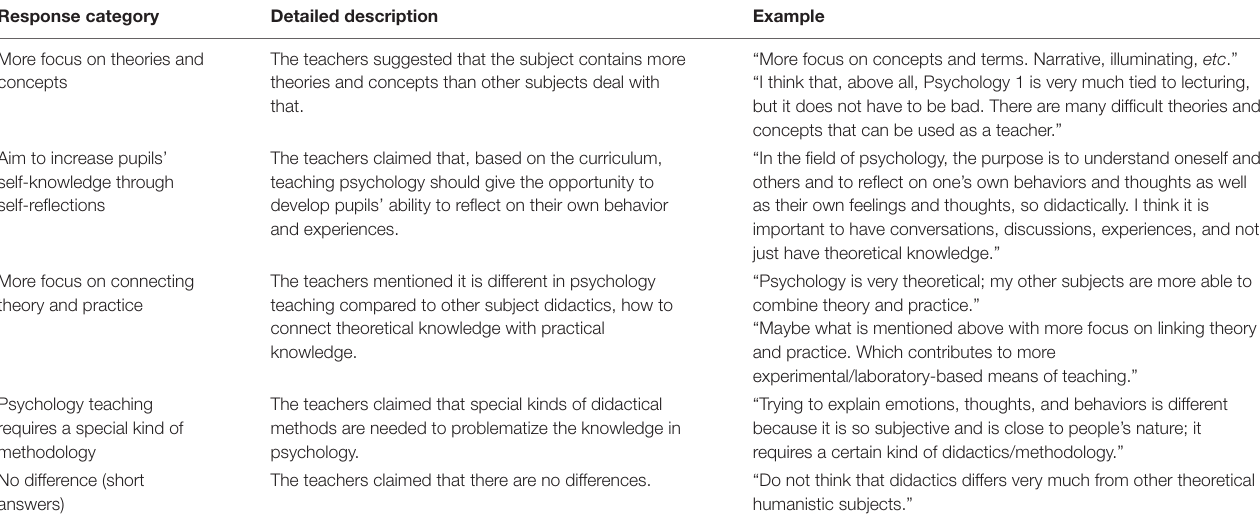
TABLE 2 | What is the difference between psychology didactics and the didactics in other